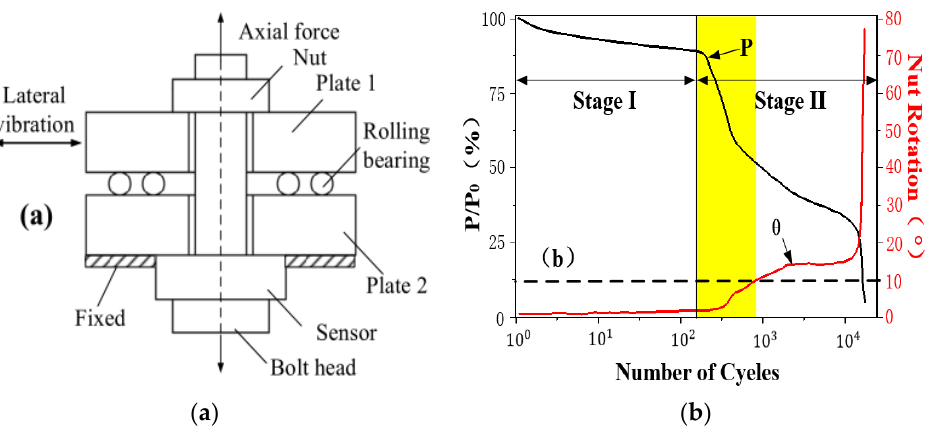
Figure 1. Experimental equipment of ( a ) bolt loosening and ( b ) curve of bolt looseness.